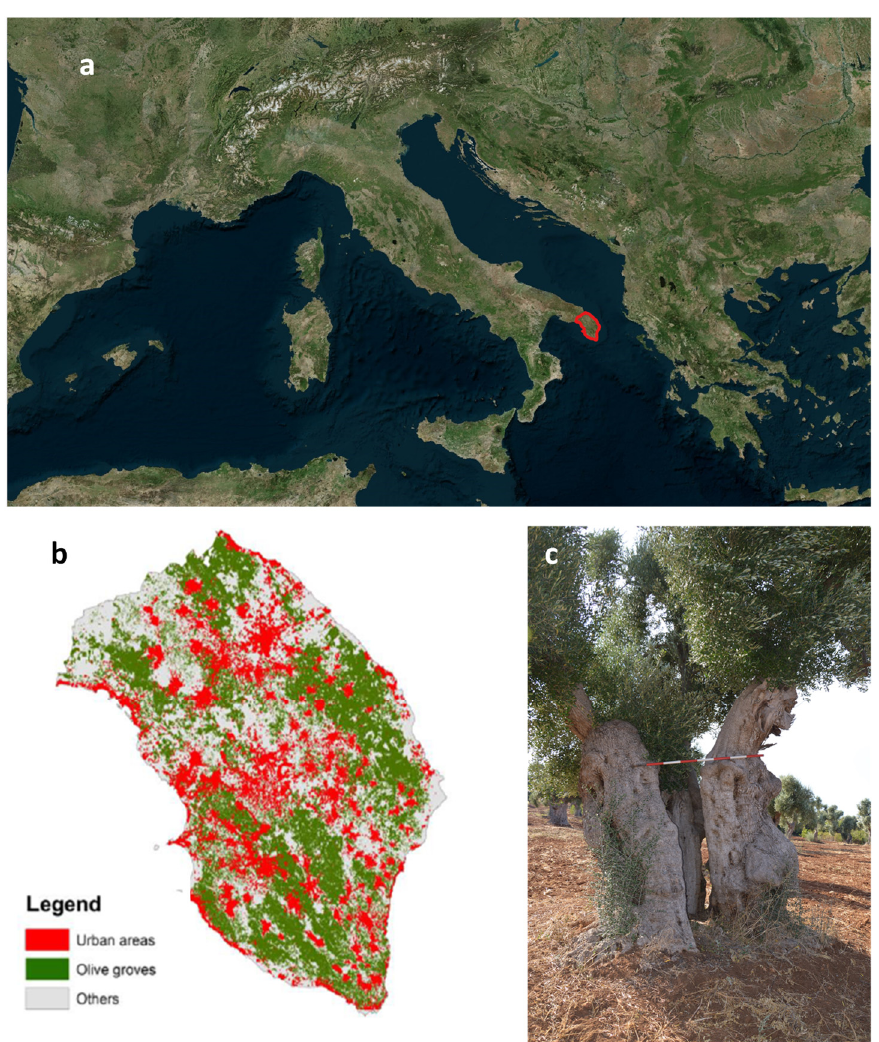
Figure 1. ( a ) Province of Lecce (red), ( b ) map of the olive grove land cover in the province and ( c ) an example of a monumental olive tree with the trunk diameter of 160 cm.